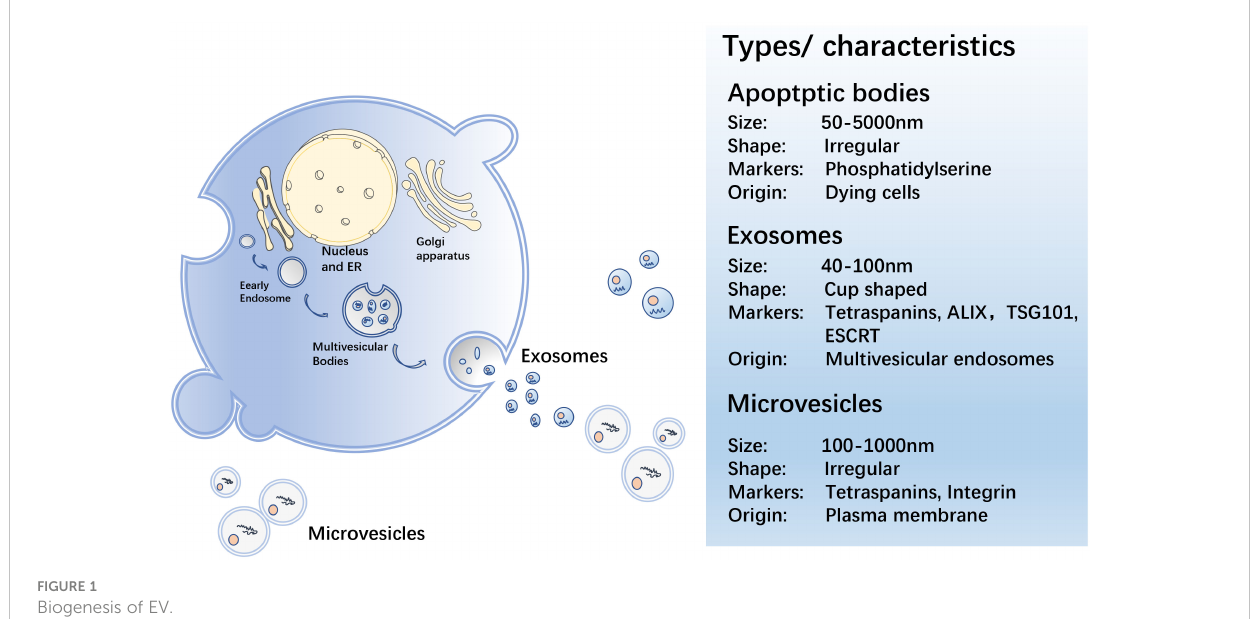
FIGURE 1 Biogenesis of